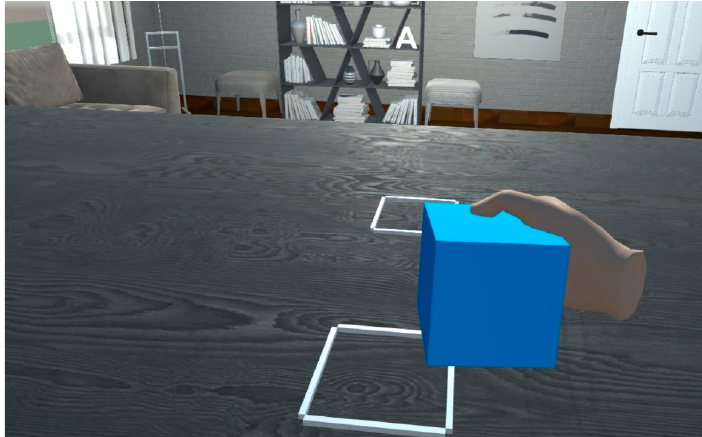
Figure 3. Exercise performance. Moving the cube from the initial to the final